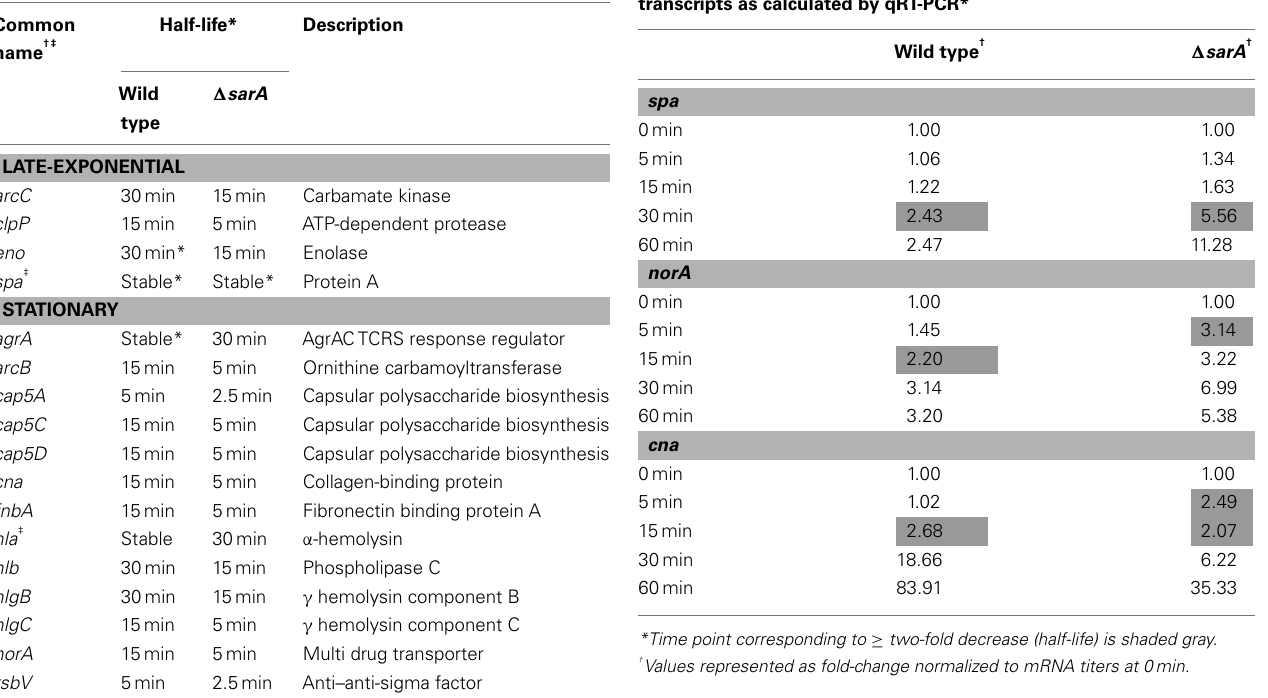
Table 4 | sarA- stabilized virulence-associated transcripts Table 5 | Stationary phase mRNA half-lives of selected virulence